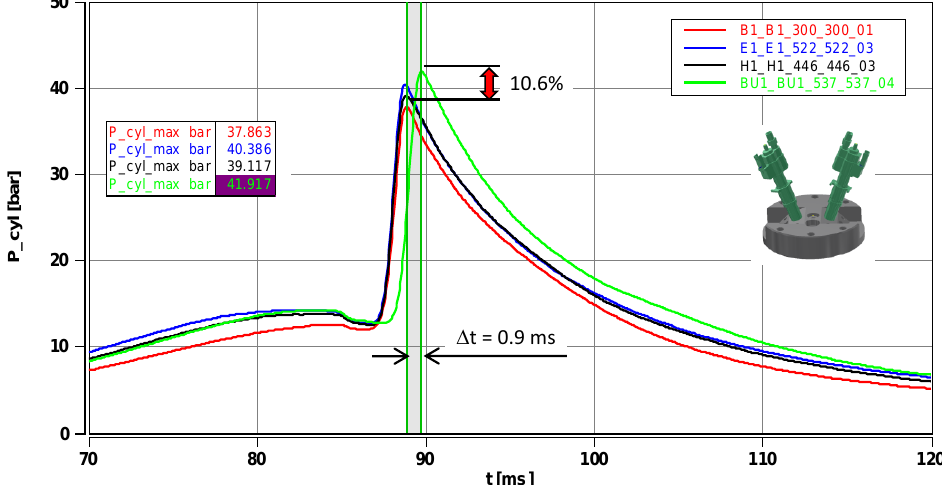
Figure 10. Comparison of time characteristics for the combustion chamber pressure in a rapid compression machine during the combustion of one type of fuel injected using two injectors along with the maximum parameter values for each of the tested cases.